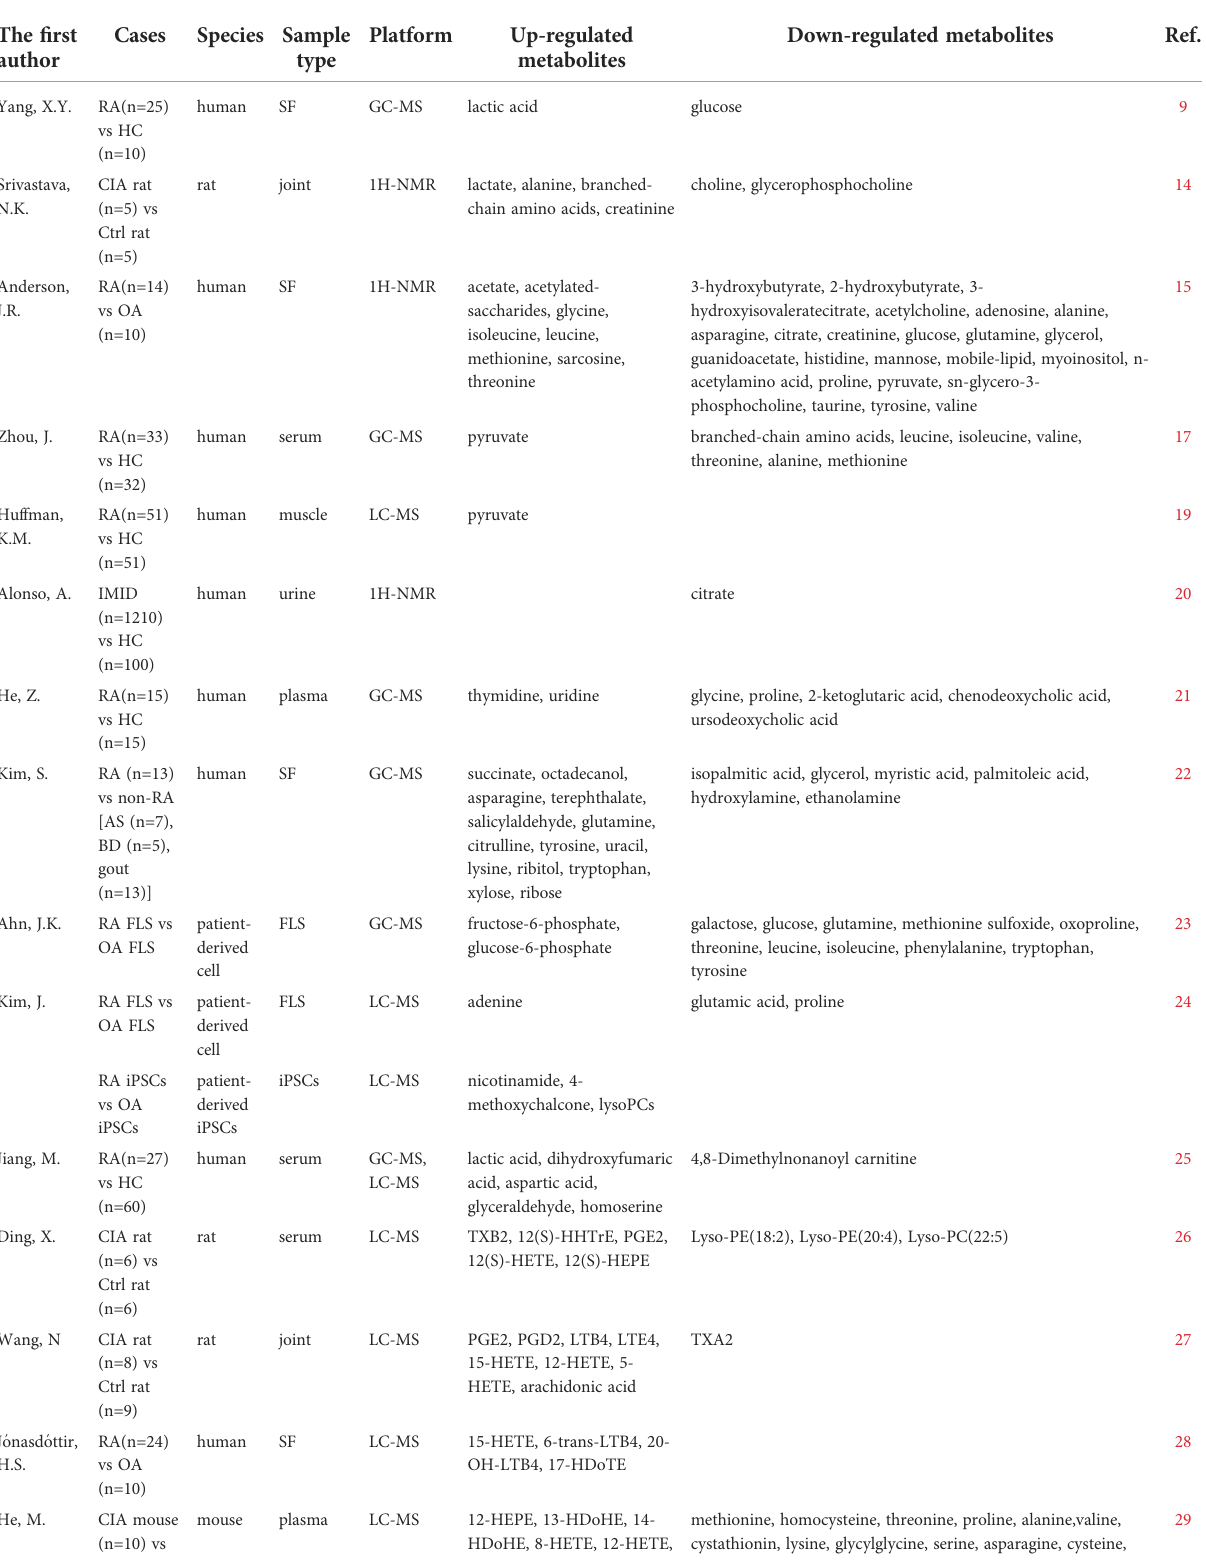
TABLE 1 Metabolites changes in rheumatoid